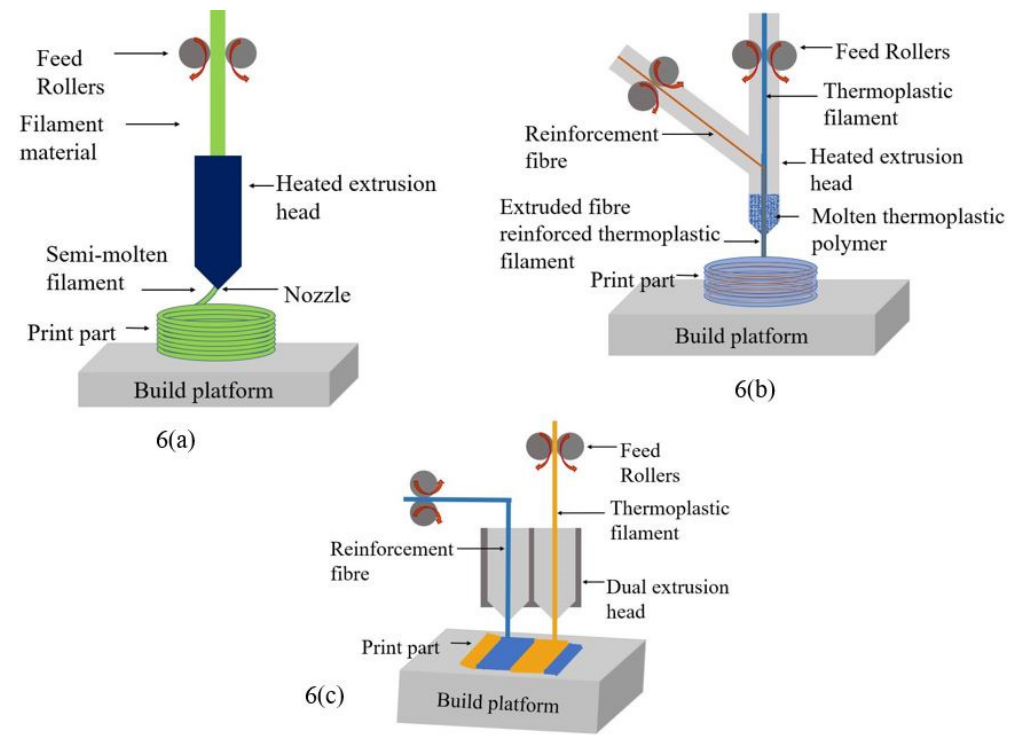
Figure 9. ( a ) Common FDM printer for polymers and short fibre-reinforced composites (SFRC). ( b ) Co-extrusion FDM printer for continuous fibre-reinforced composites (CFRC). ( c ) Dual-Extrusion FDM printer for CFRC.